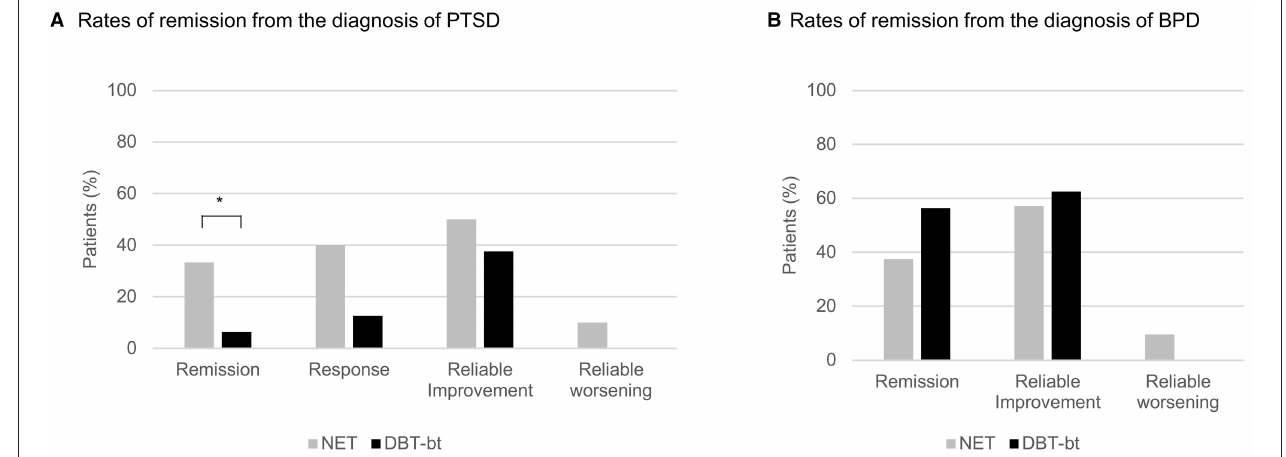
FIGURE 2 | (A) Total Clinician-Administered PTSD Scale for DSM-IV [CAPS; (19)] scores of participants randomized to Narrative Exposure Therapy (NET; gray color) or Dialectical Behavior Therapy (DBT) based treatment (DBT-bt; black color) before therapy and at 12-months follow-up. Values below the main diagonal indicate improvements; the dotted diagonals show reliable change. (B) Rates of remission from the diagnosis of PTSD as well as response, reliable improvement and worsening. Data are presented for the treatment completer sample, for the intention-to-treat sample see Supplementary Figure S2 in the Supplementary Material . * p ≤